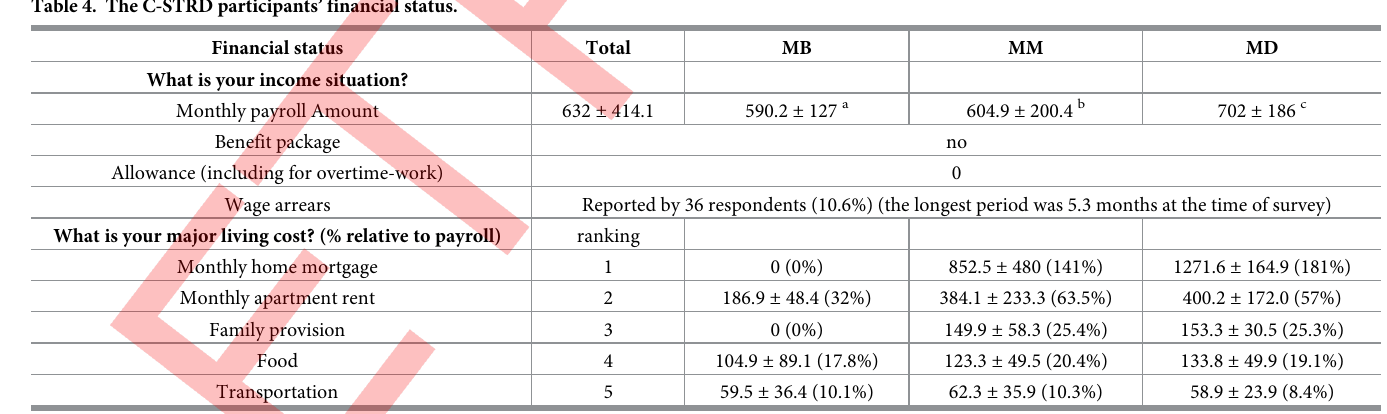
Table 4. The C-STRD participants’ financial